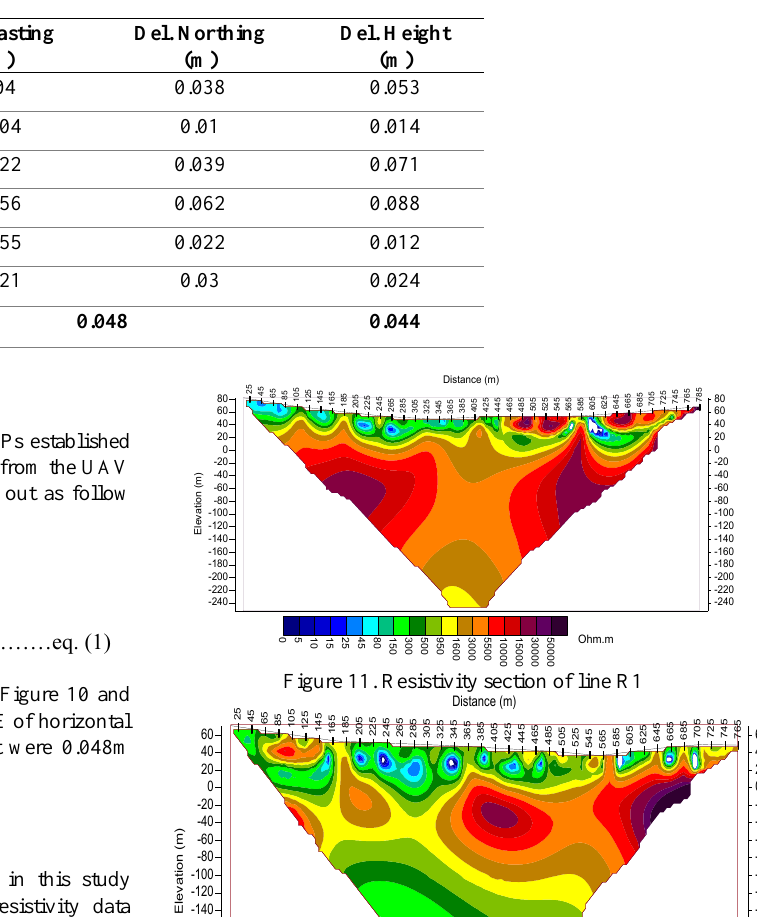
Table 2: RMSE of horizontal and vertical component.